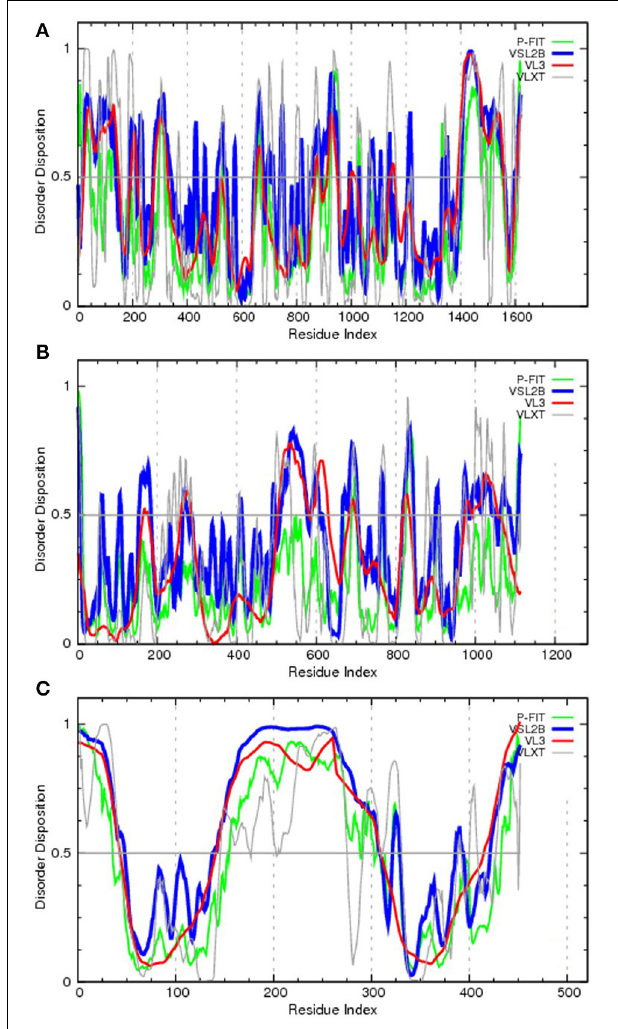
FIGURE 3 | Evaluating the disorder propensities of proteins commonly affected by chromosomal translocation: ALK (A), RET (B), and ETV6 (C). The disorder propensities are evaluated by the members of the PONDR family of disorder predictors. Here, scores above 0.5 correspond to disordered residues/regions. PONDR ® VSL2B is one of the most accurate stand-alone disorder predictors (Obradovic et al., 2005), PONDR ® VL3 possesses high accuracy in finding long IDPRs (Obradovic et al., 2003), PONDR ® VLXT is not the most accurate predictor but has high sensitivity to local sequence peculiarities which are often associated with disorder-based interaction sites (Dunker et al., 2001), whereas PONDR-FIT represents a metapredictor which, being moderately more accurate than each of the component predictors, is one of the most accurate disorder predictors (Xue et al., 2010b).